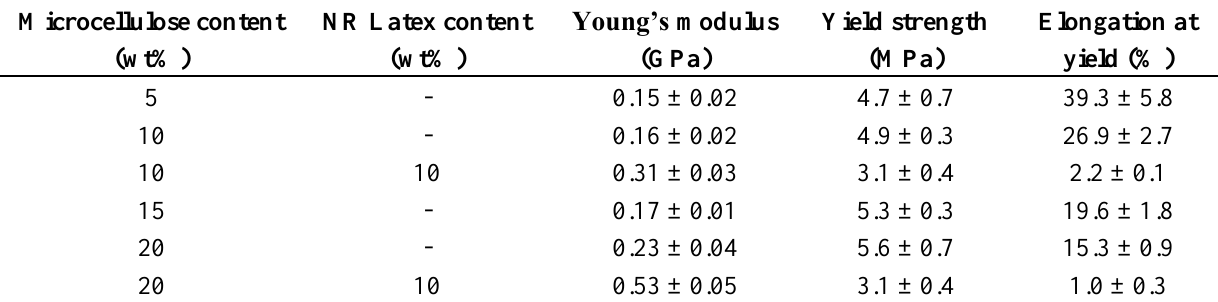
Table 3. Mechanical properties of thermoplastic starch (TPS) based composite systems filled with different amount of microfibrillated